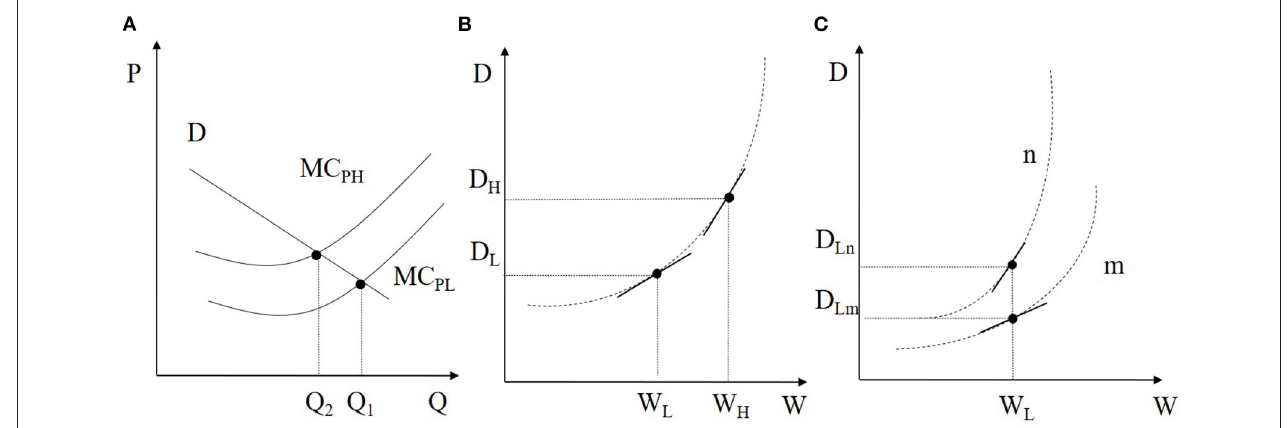
FIGURE 1 | (A–C) Differences in marginal damage from pollution and impacts under different scenarios.